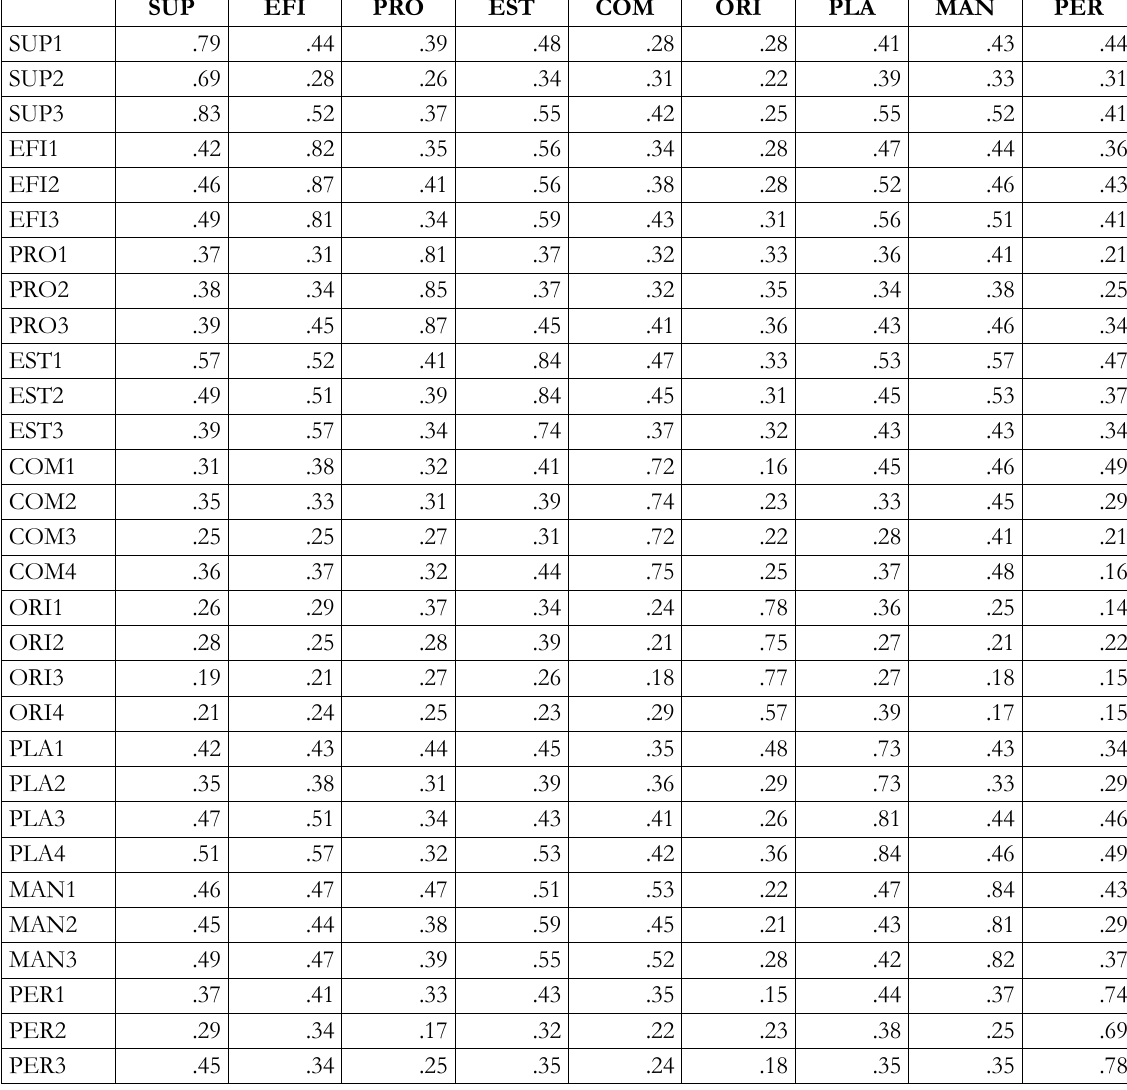
Table 5. Discriminant validity according to the cross-loadings